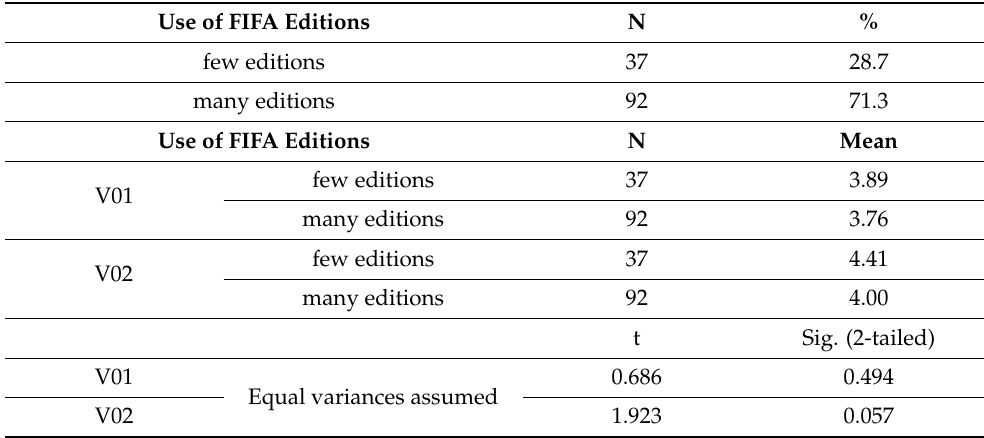
Table 11. Comparison (considering V01 and V02) between those who experienced few or many FIFA game